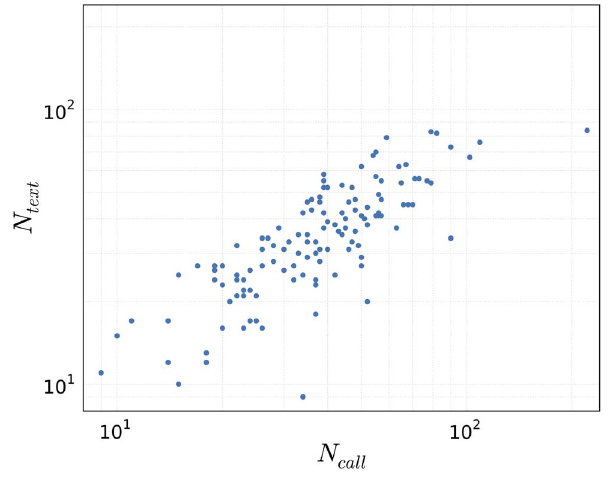
Figure 9. Diversity of communication logs. Diversity is estimated as the set of unique numbers that a person has contacted or been contacted by in the given time period on a given channel. We note a strong correlation in diversity (Pearson correlation of 0 : 75 , p % 0 : 05 ), whereas the similarity of the sets of nodes is fairly low (on average S s T ~ 0 : 37